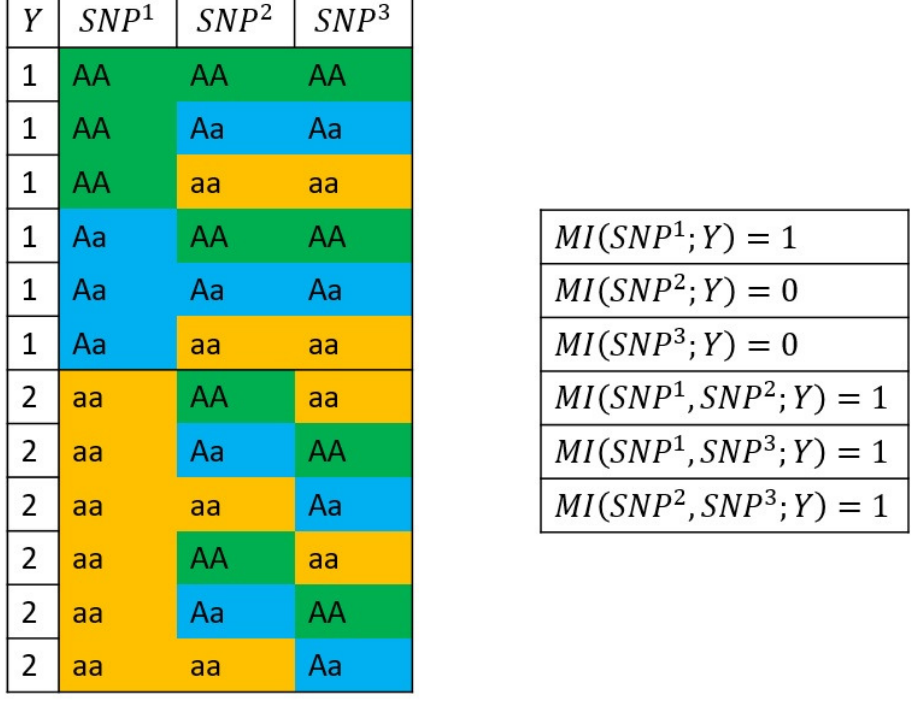
Figure 5. Example of MI values calculated from genotype data for three SNPs and twelve samples with a binary phenotype. The table cells are colored based on the genotype value of the SNP for the corresponding